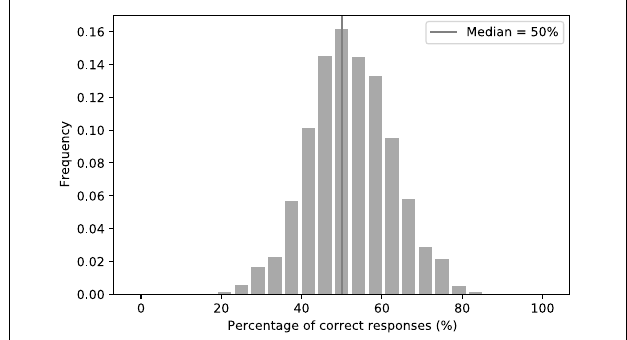
FIGURE 4 | Histogram of the percentage of correct responses in the Turing test on discriminating between the synthetic and the natural videos. The median was exactly at the chance level of 50%.